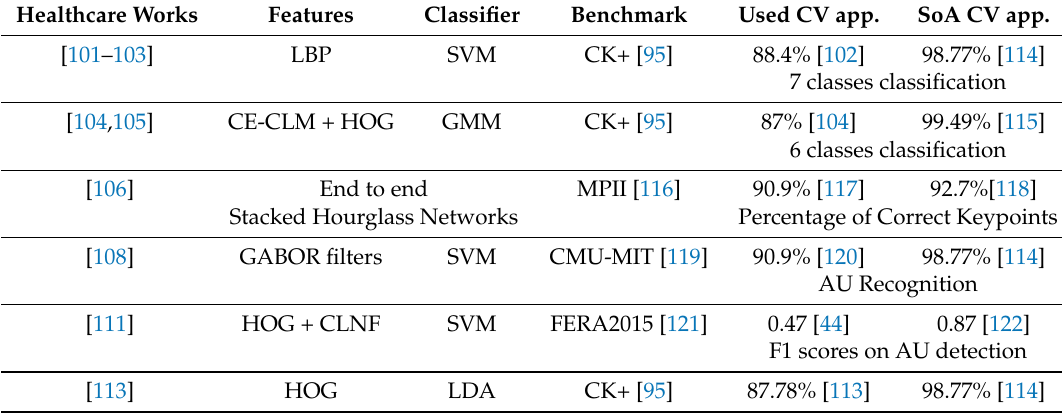
Table 2. Facial expression recognition: The computer vision approaches used in the healthcare-related works and their comparison with up-to-date works in the